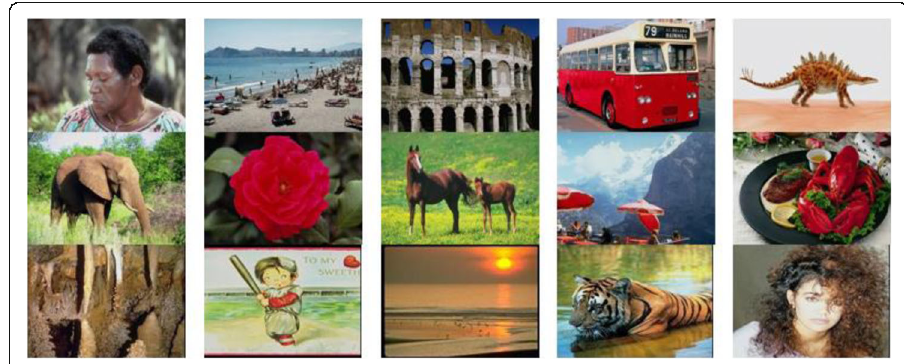
Fig. 9 Sample images (one per category) of the Corel 1500 image dataset [49]